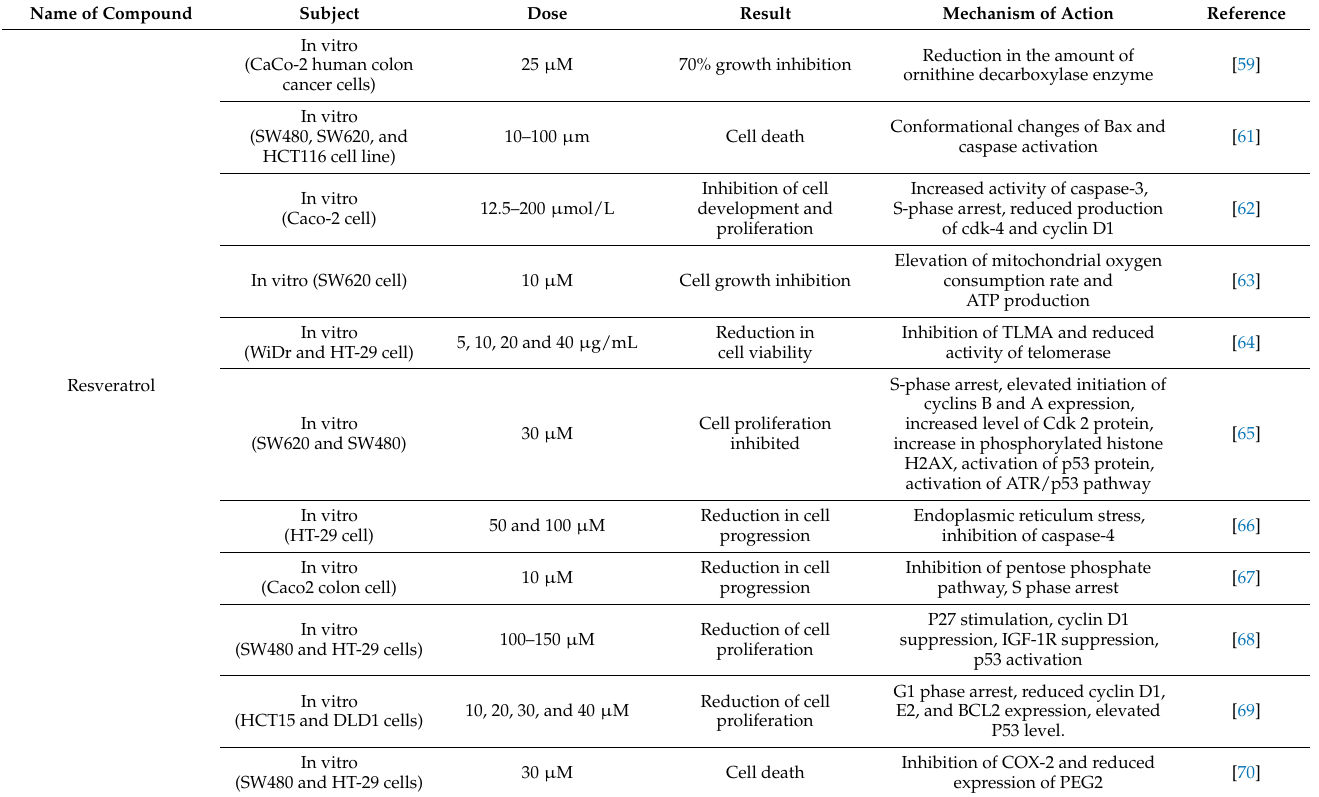
Table 2. Natural small molecules in colon